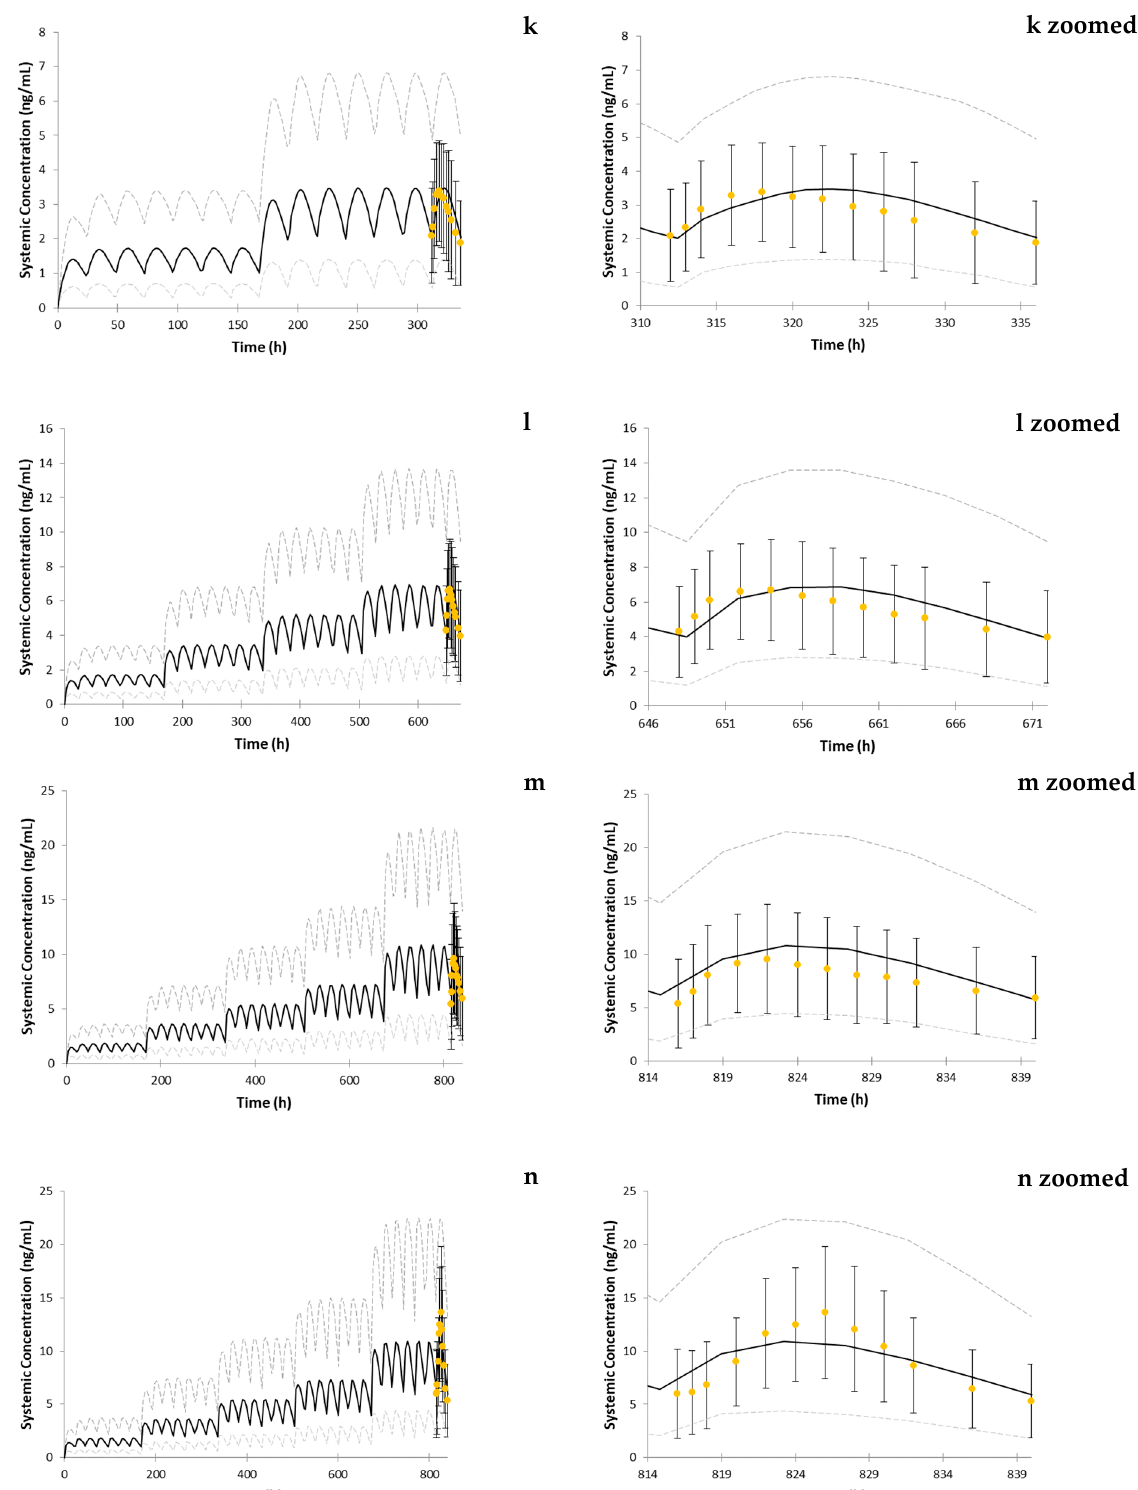
Figure 3. Mean observed (circles) and simulated (solid line) systemic plasma concentration–time profiles of ropinirole. Variability of the observed data is provided as SD if reported in the study; 5%th and 95%th percentiles are presented as grey dashed lines. Design of studies is provided in Table 2. Each Latin letter in this figure is a reference to the Simulation ID in Table 2. Multiple dose simulations additionally zoomed (e.g., f–n zoomed) in the time period where the observed data was available.